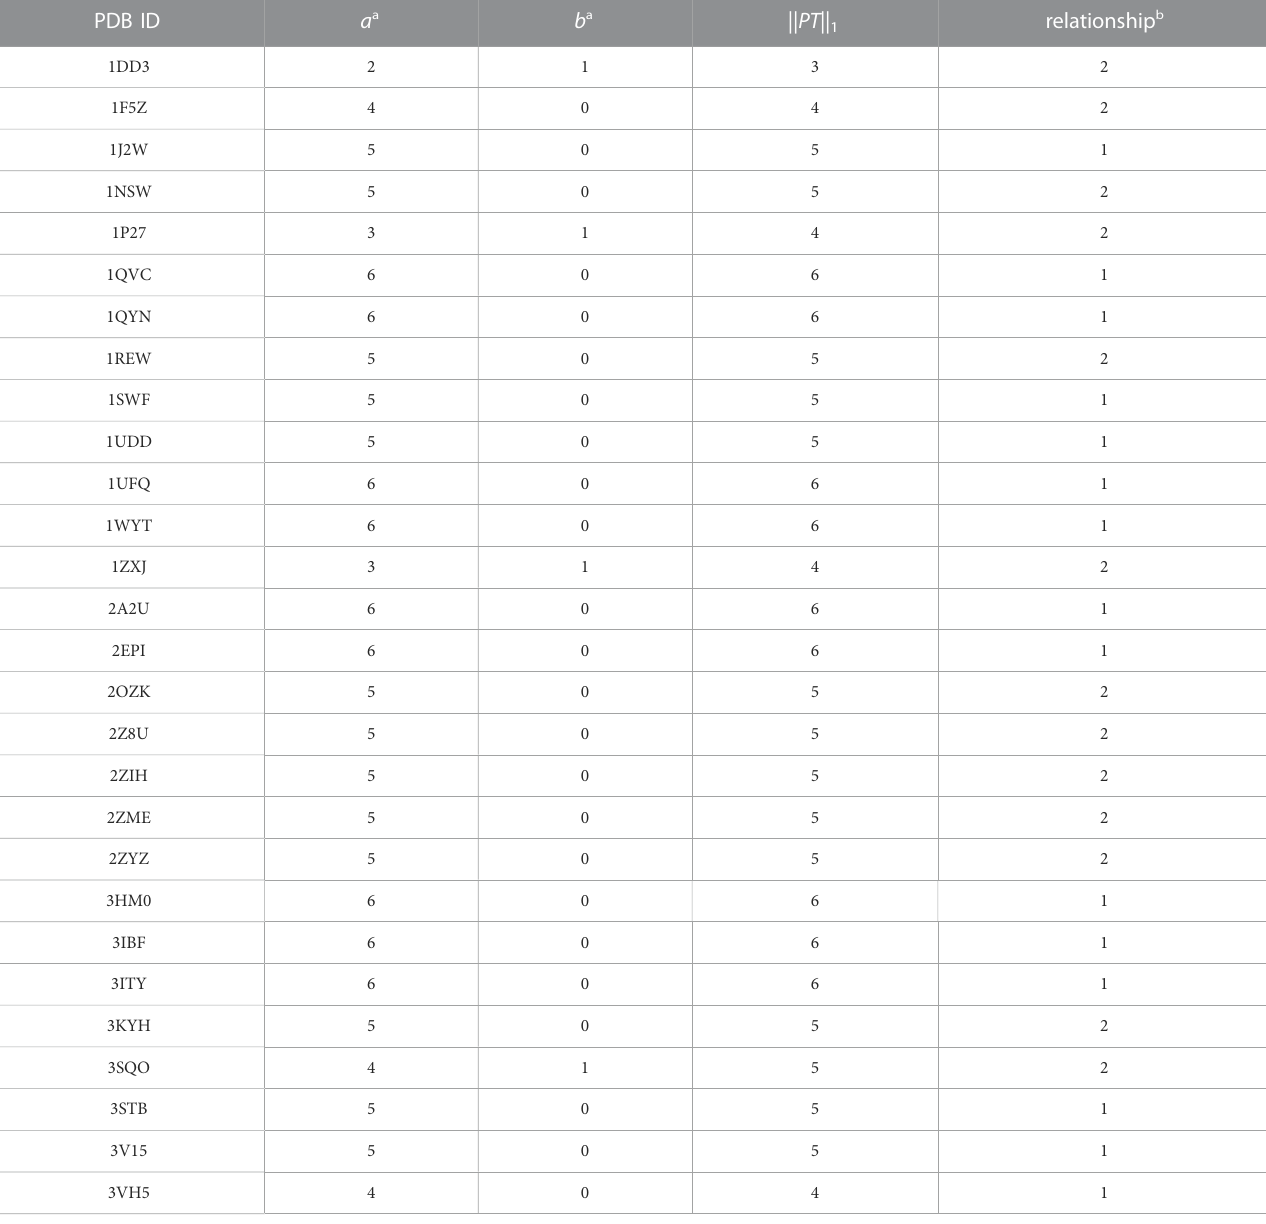
TABLE 3 Prediction of each tetramer protein complex in testing